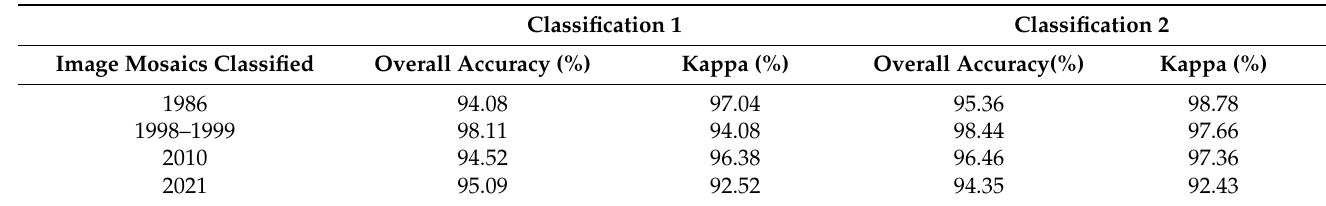
Table 3. Overall accuracy and Kappa coefficient values from supervised classifications of Landsat image mosaics of the Port-au-Prince agglomeration from 1986, 1998–1999, 2010 and 2021 based on the maximum likelihood algorithm.